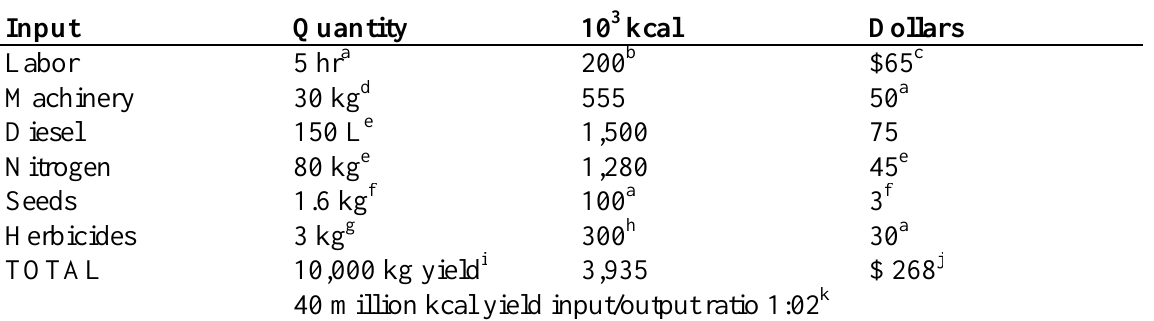
Table 6. Average inputs and energy inputs per hectare per year for switchgrass